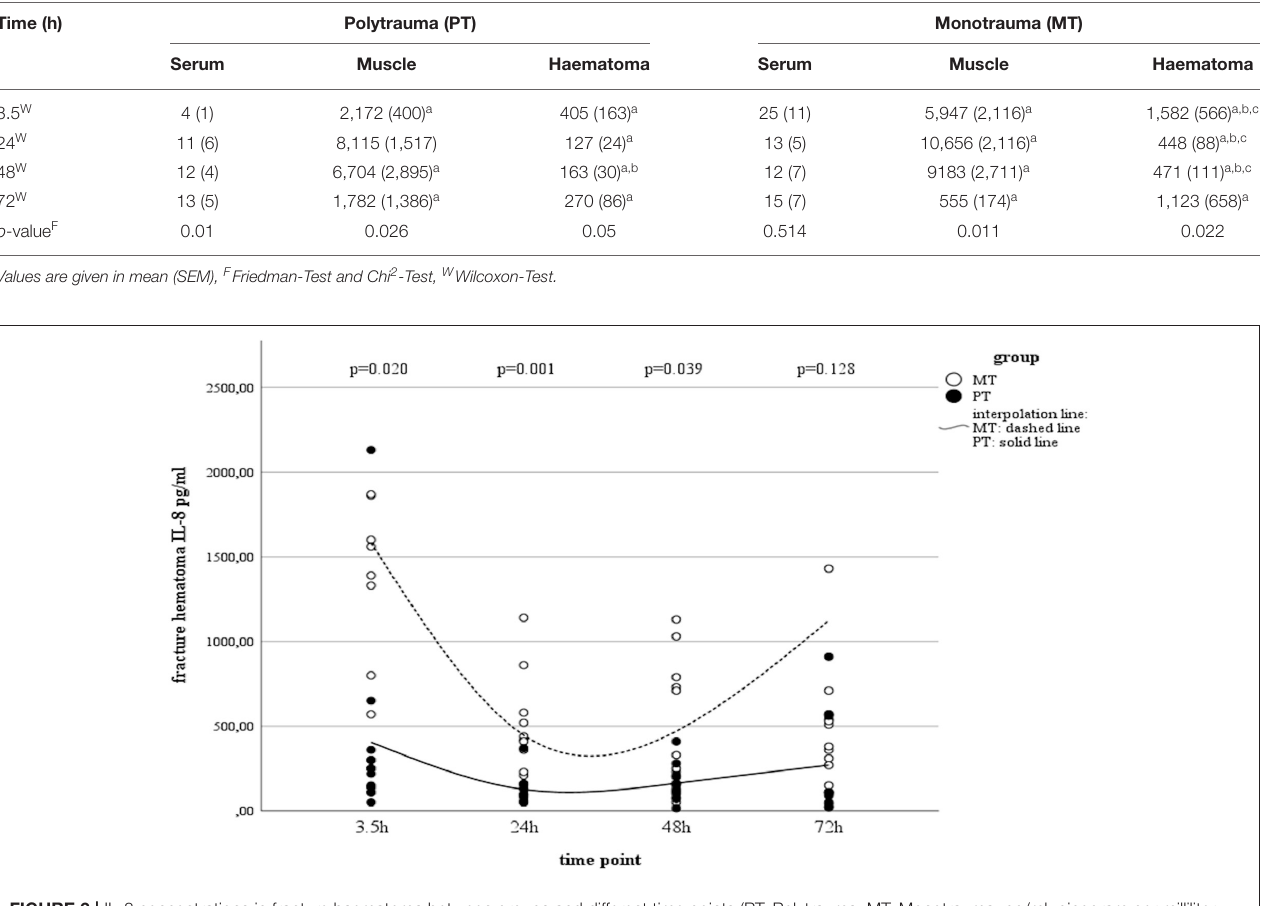
FIGURE 2 | IL-8 concentrations in fracture haematoma between groups and different time points (PT, Polytrauma; MT, Monotrauma; pg/ml, picogram per milliliter; h,